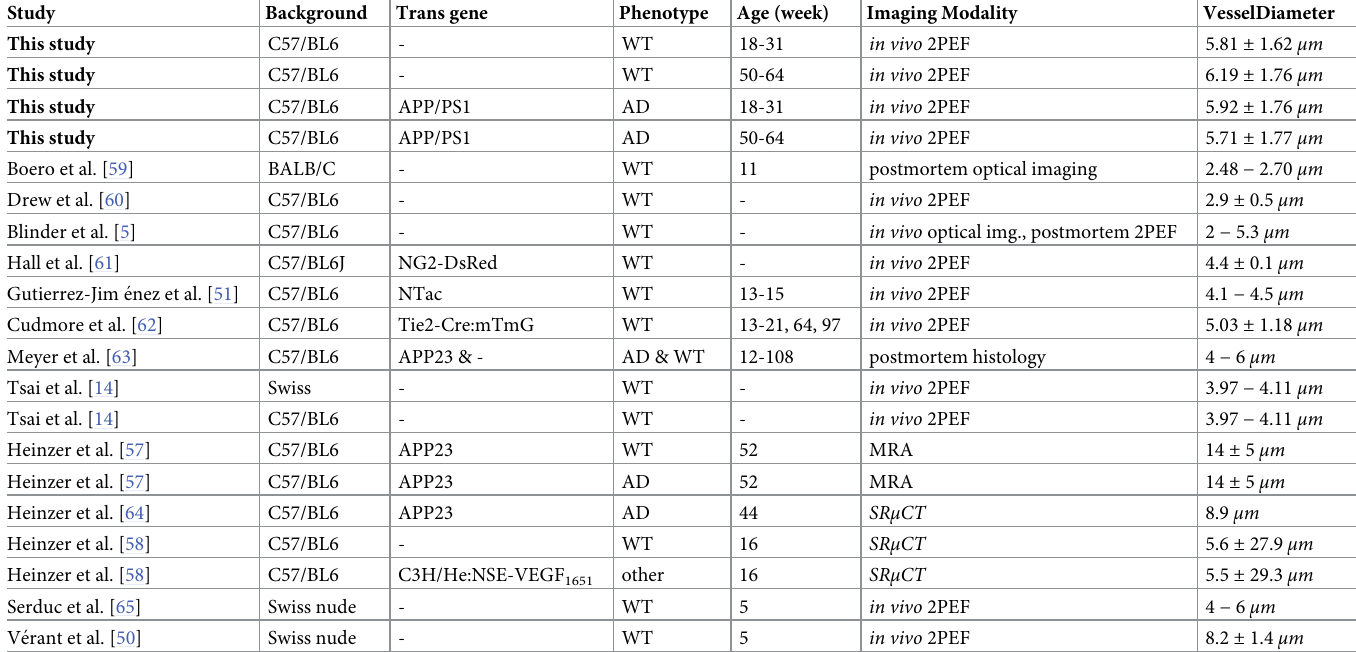
Table 3. Comparison of measured mouse capillary diameters from different